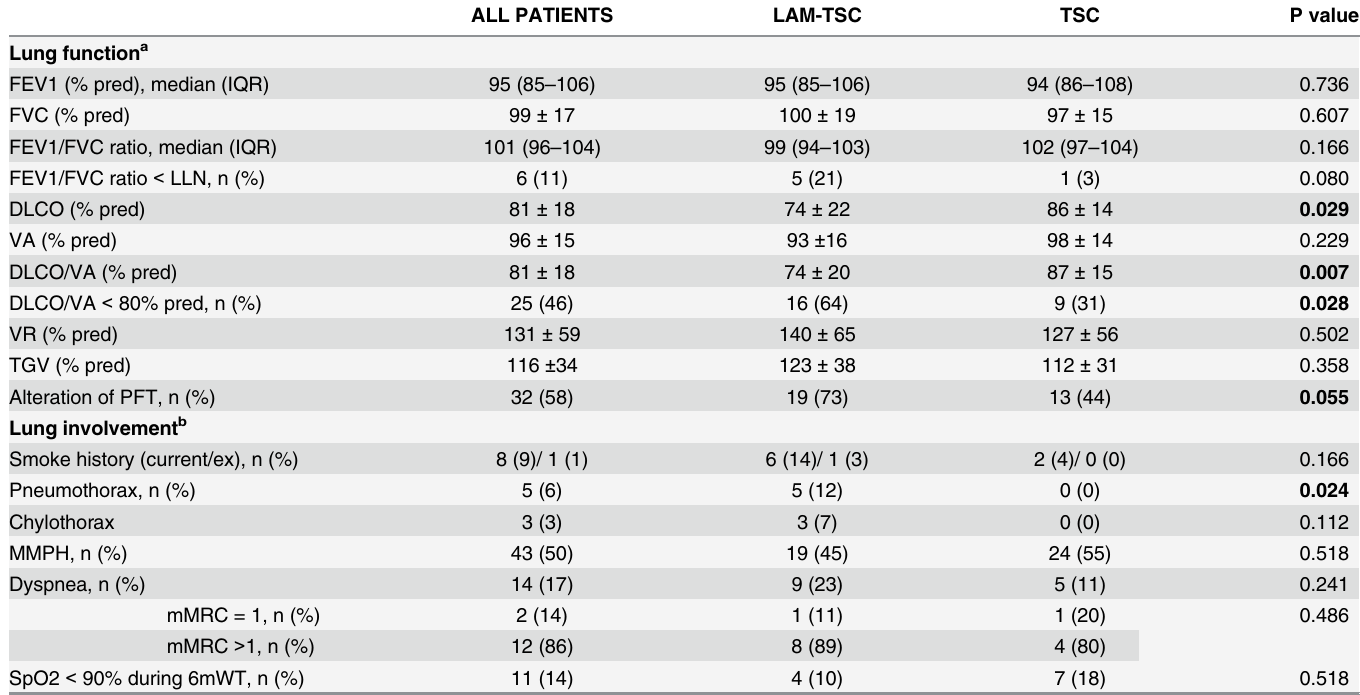
Table 2. Lung function, pulmonary manifestations and symptoms of patients according with LAM. ALL PATIENTS LAM-TSC TSC P value Lung function